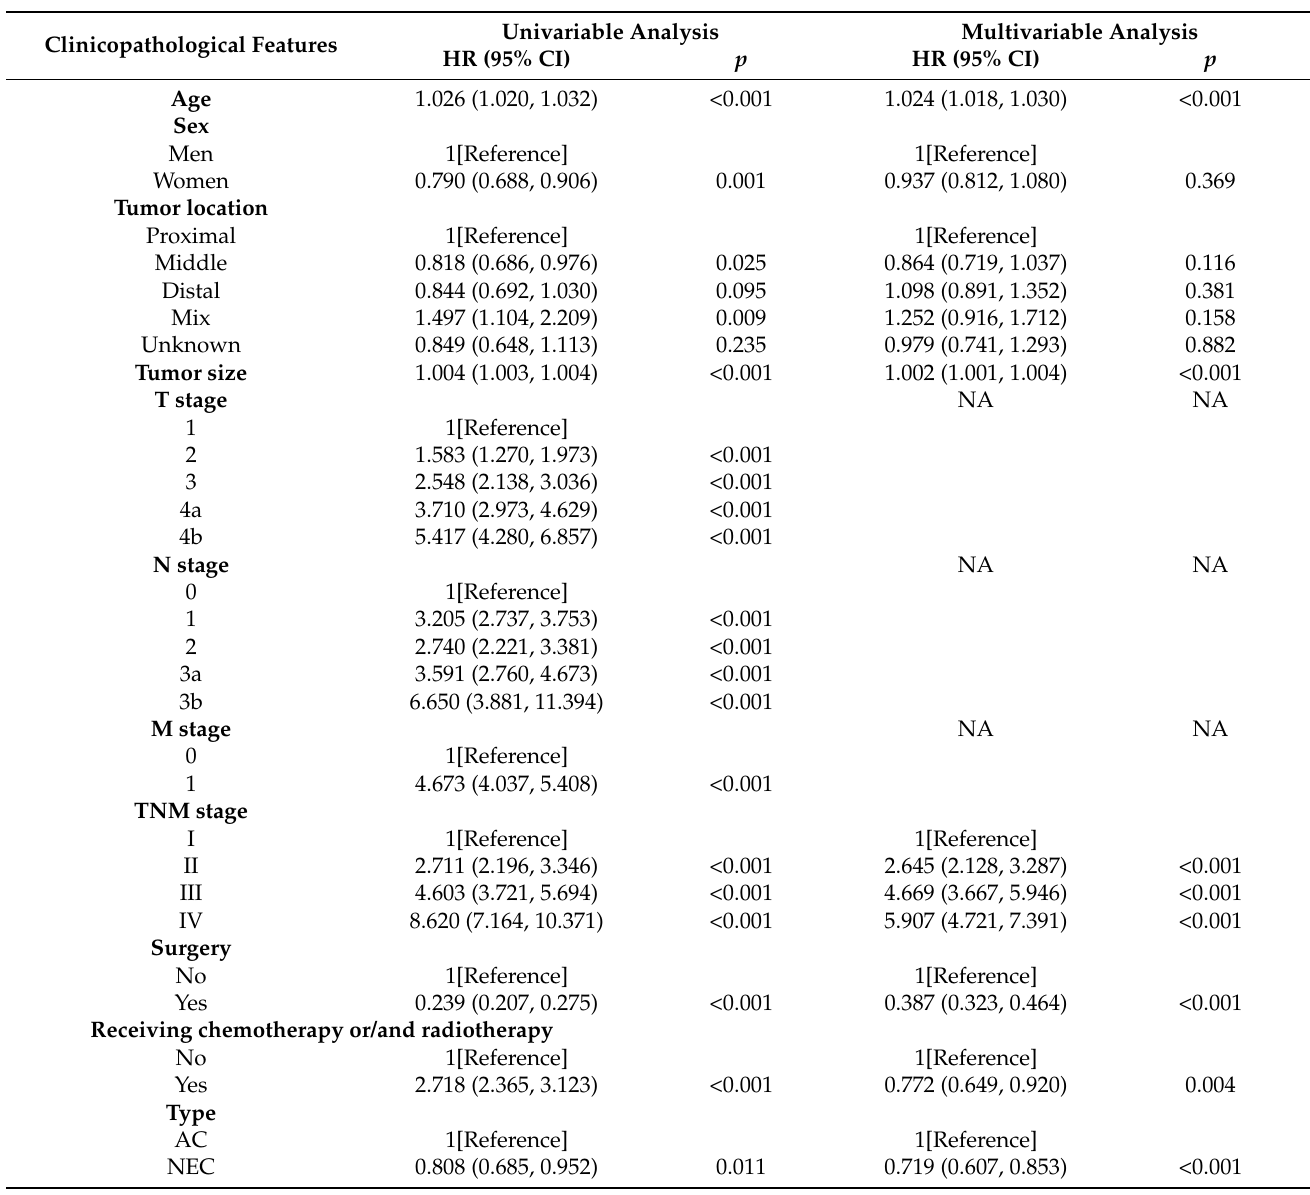
Table 3. Univariable and Multivariable Cox Regression Analyses of Factors Associated with Overall Survival of White Patients with Gastric Neuroendocrine Carcinoma and Adenocarcinoma in the Matched